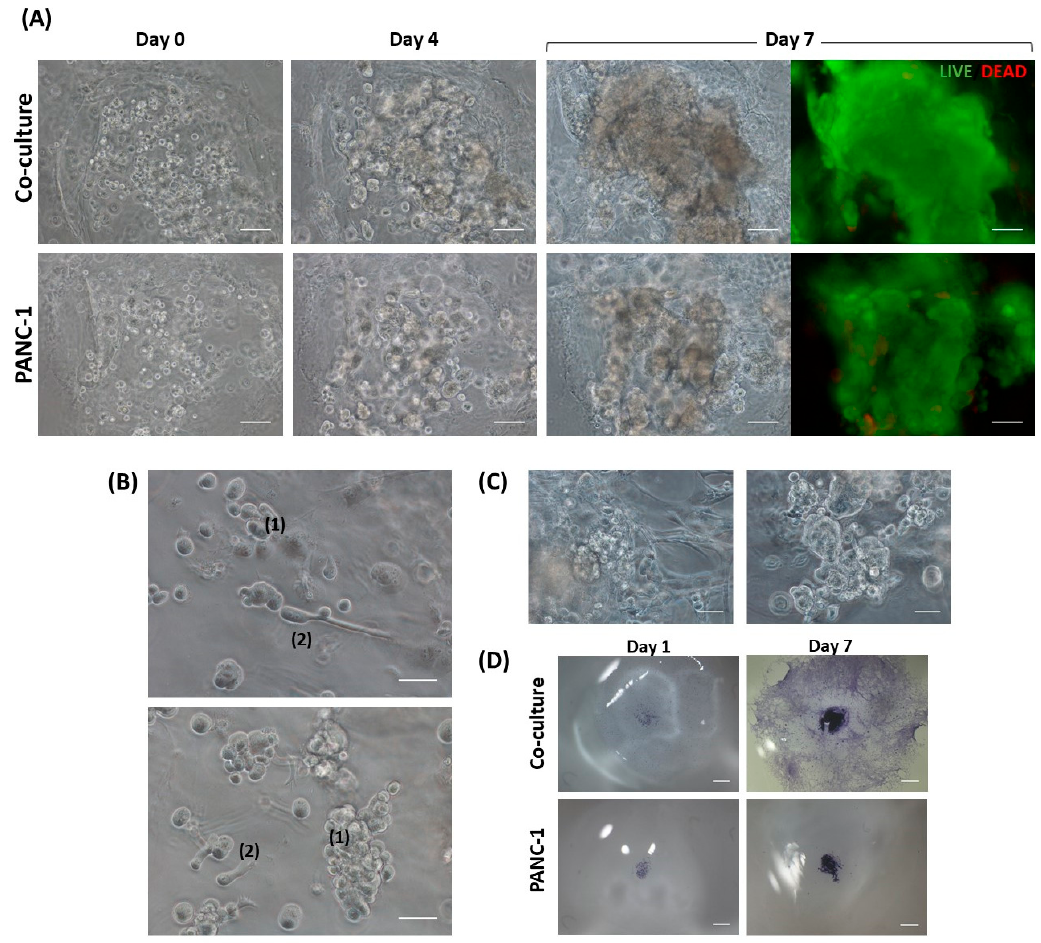
Figure 2. 3D culture evolution. ( A ) Tumor core progression in co-culture and PANC-1 monoculture. Comparison of the tumor core in the co-culture ( top ) and PANC-1 monoculture ( bottom ) reveals more compacted PANC-1 clusters when monocultured. Live/Dead staining at day 7 shows high cell viability in both cases. Scale bar: 100 µm. ( B ) PANC-1 phenotypes in 3D co-culture. Close-up sections of the 3D co-culture at day 2 from the injection show epithelial-to-mesenchymal transition in PANC-1 cells. (1) PANC-1 colonies with epithelial phenotype, (2) PANC-1 cells with mesenchymal phenotype. Scale bar: 50 µm. ( C ) Close-up sections of 3D co-culture ( left ) and PANC-1 monoculture ( right ) at day 7. As PANC-1 colonies grow, physical interactions with fibroblasts are established. Scale bar: 50 µm ( D ) Stereoscopic microscopy images of 3D cultures. Co-culture ( top ) and PANC-1 monoculture ( bottom ) stained with toluidine blue at day 1 and 7 from the injection. Scale bar: 1 mm.